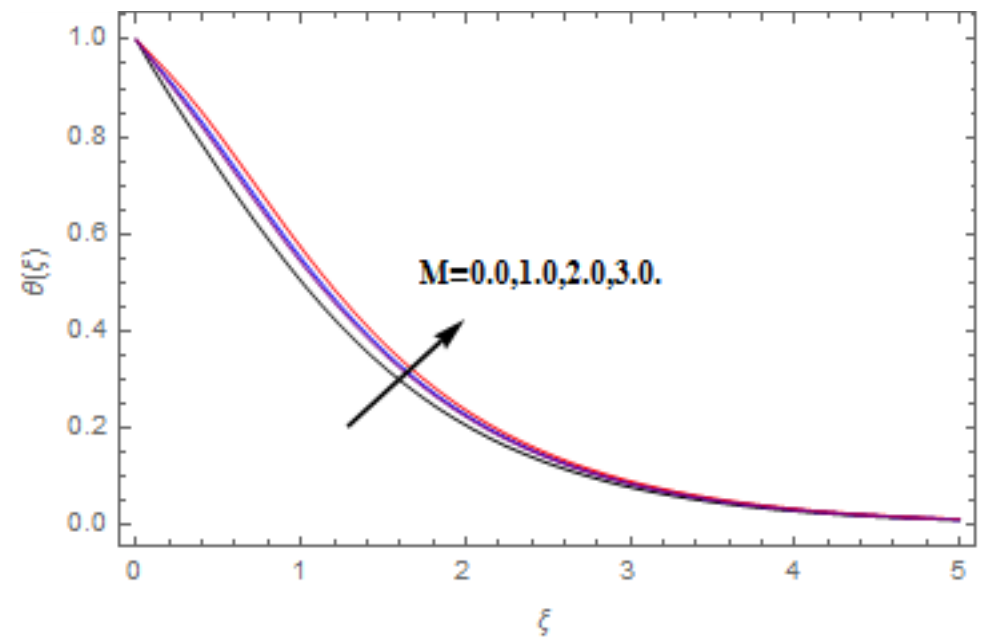
Figure 10. Varation in θ ( ξ ) against M , when ψ = 0.2, Nt = Nb = 0.5, Le = 1.0, Ec = 1.0, Pr = 1.2, γ = 0.1, κ =